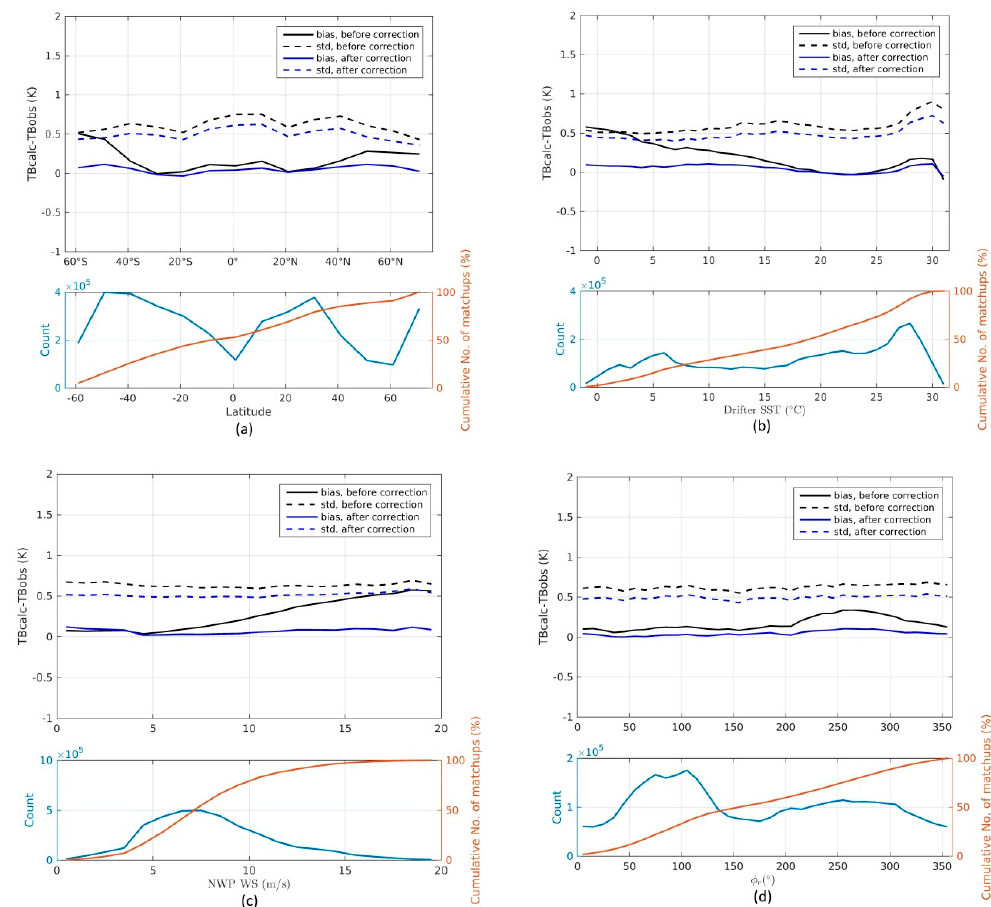
Figure 5. Mean simulated minus observed brightness temperatures for all channels against ( a ) Latitude; ( b ) Drifter SST; ( c ) NWP WS; ( d ) NWP wind direction relative to azimuthal satellite look. Dashed lines are standard deviations and solid lines are biases. The black and blue colors denote differences before/after the empirical bias correction has been applied. The bottom plots show the number of matchups (blue) and the cumulative percentage of matchups (red) for each data bin.